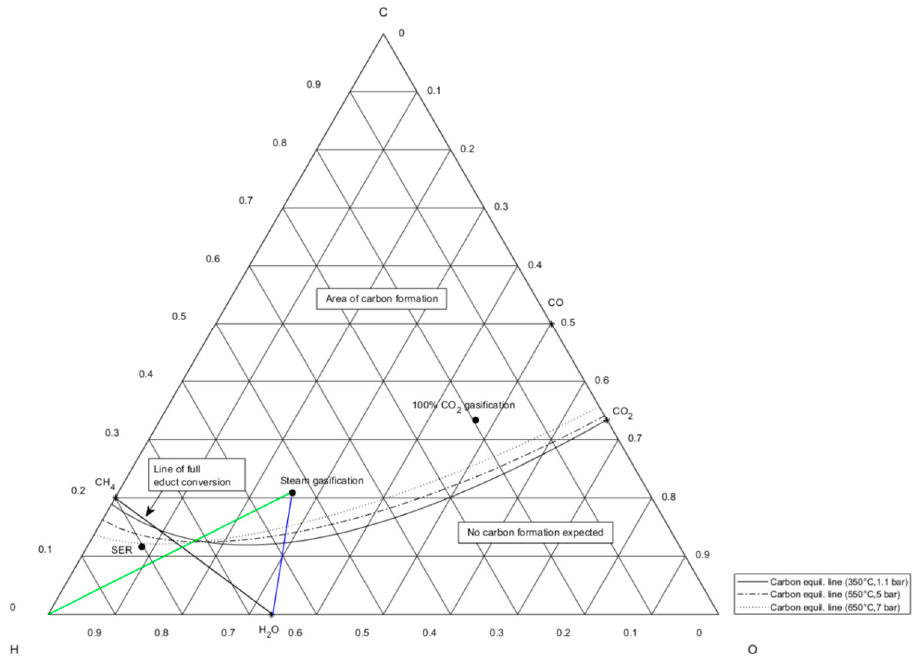
Figure 6. Ternary C ‐ H ‐ O ratio diagram showing carbon equilibrium lines at different temperature and pressure levels and fractional compositions of syngas from Table